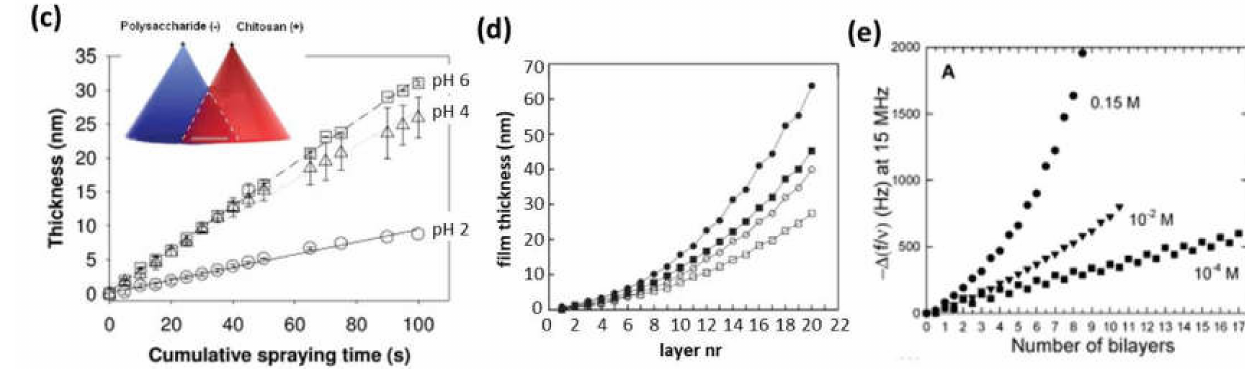
Figure 3. ( a ) Thickness of (CMCHI/CHI) n built-up by spray using LMW chitosan (blue curve) or MMW chitosan (red curve) and AFM topographic images of multilayer films with 20 layer pairs (Adapted and reprinted with permission from [45]; Copyright 2012 Maria A. Witt et al.); ( b ) Thickness, measured by surface plasmon resonance (SPR) and ellipsometry, of CHI-based films assembled in the presence of different polyanions (i.e., HA, CHS, and HEP) (Reprinted with permission from [51]; Copyright 2011 American Chemical Society); ( c ) Thickness of CHI/CHS films built up by simultaneous spraying at a fixed salt concentration of 150 mM NaCl at different pHs: 2 ( ), 4 ( (cid:52) ), and pH 6 ( (cid:3) ) (Adapted and reprinted with (cid:35) permission from [52]; Copyright 2012 American Chemical Society); ( d ) Film thickness after sequential deposition of CHI and HEP at different ionic strengths and pHs: 150 mM NaCl and pH 5.8 ( • ), 150 mM NaCl and pH 4.2 ( (cid:4) ), 30 mM NaCl and pH 5.8 ( ), and 30 mM NaCl and pH 4.2 ( (cid:3) ) (Adapted and reprinted with permission from [42]; Copyright 2011 American (cid:35) Chemical Society); ( e ) Differences in the QCM frequency shifts at 15 MHz for CHI/HA multilayer films at pH 5 and different NaCl concentrations (0.15 M, 10 − 2 M, and 10 − 4 M NaCl) (Reprinted with permission from [25]. Copyright 2004 American Chemical